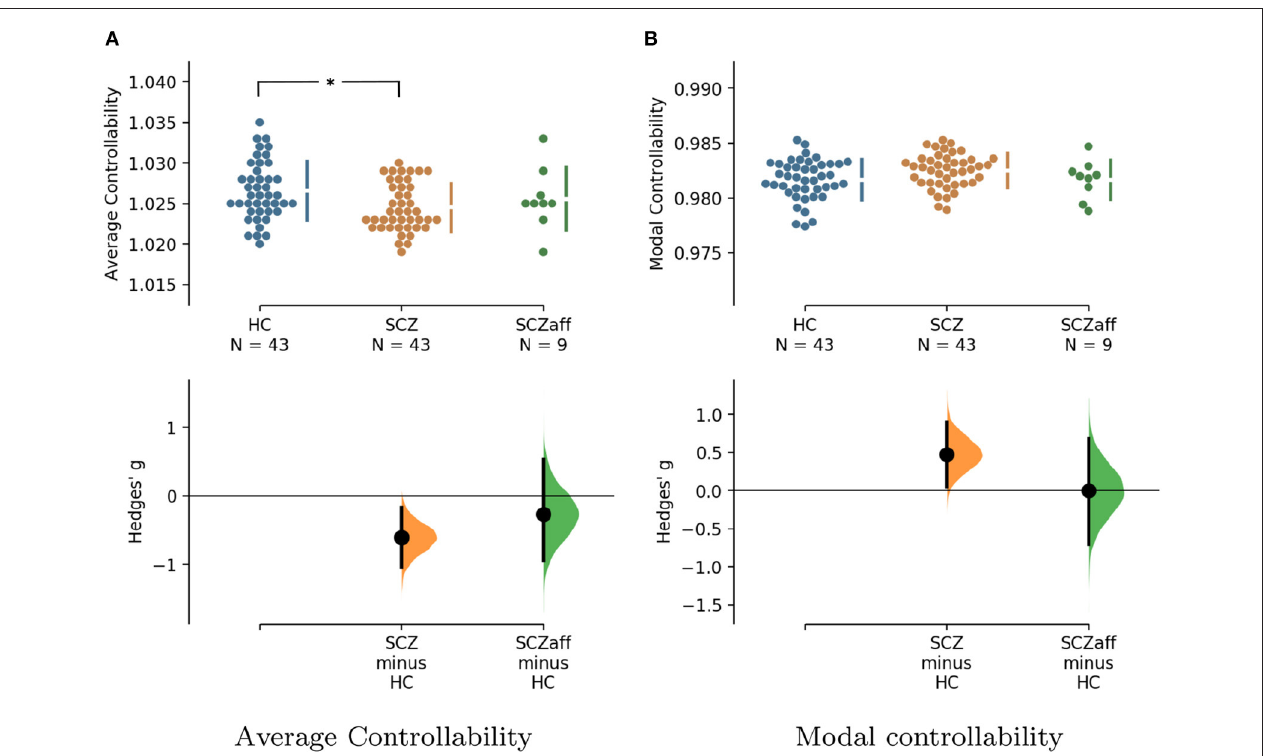
FIGURE 3 | Hedge’s g for the comparisons of (A) average and (B) modal controllability of weighted graphs of the SCZ and SCZaff groups against the HC group are shown in the above Cumming estimation plot. The raw data is plotted on the upper axes. On the lower axes, Hedge’s g is plotted as bootstrap sampling distributions. Each g is depicted as a dot. Each 95% confidence interval is indicated by the ends of the vertical error bars [see ( 30)]. *Denotes statistically significant differences at a significance level of 0.05 Bonferroni corrected.